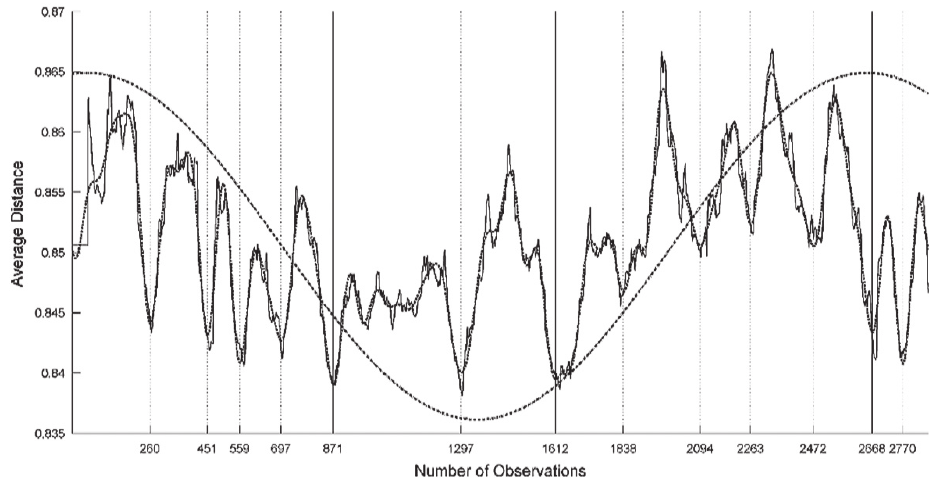
Fig. 6. Low frequency components of average